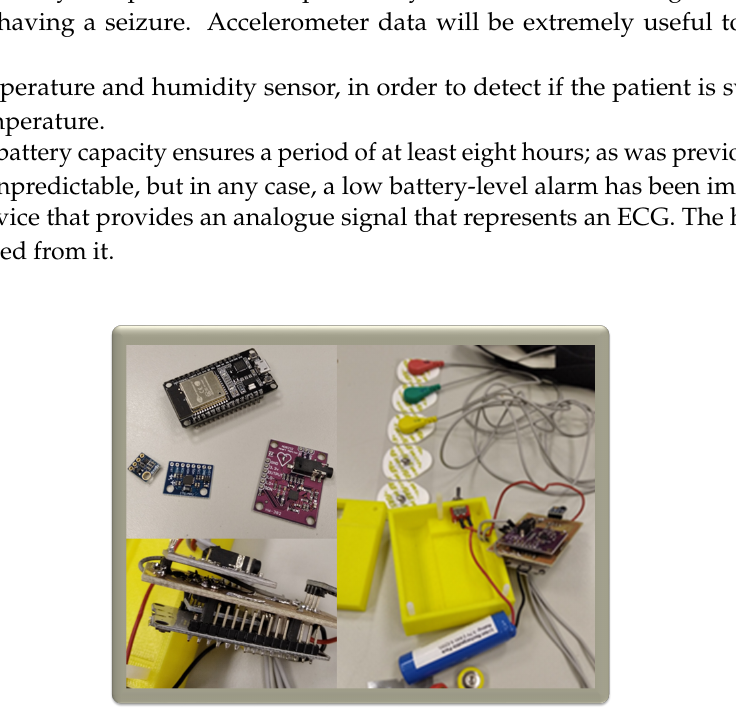
Figure 7. Some prototype pictures. It was tested on some of the authors under mechanical contention, following a protocol designed by psychiatric